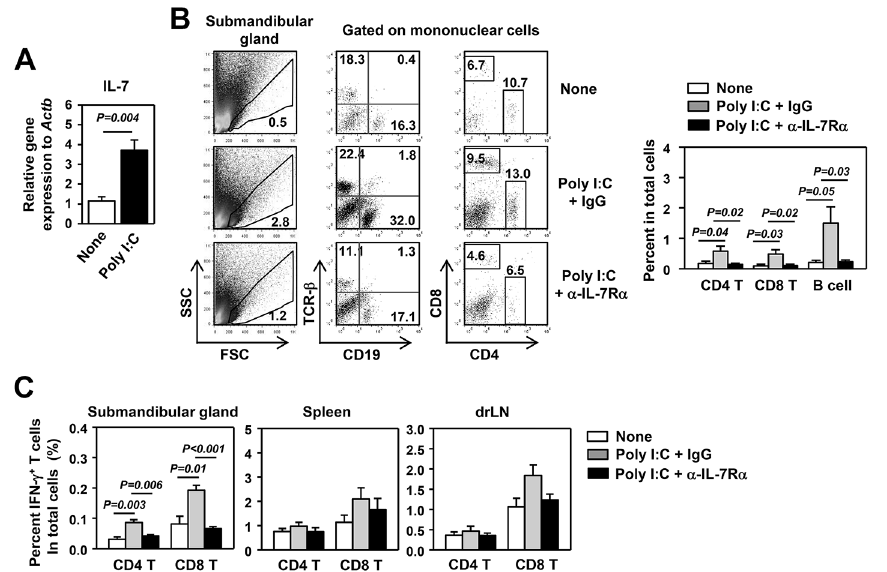
Figure 5. Poly I:C enhances Th1 and Tc1 responses in an IL-7-dependent manner. B6.NOD- Aec mice were injected with poly I:C plus IgG or anti-IL-7Rα antibody as described in Figure 4. (A) IL-7 mRNA levels in the submandibular glands of non-poly I:C- or poly I:C-treated B6.NOD- Aec mice. (B) Flow cytometric analyses of leukocyte subpopulations among mononuclear cells in submandibular glands. (C) Percentage of IFN-γ + T cells in total submandibular gland cells, splenocytes and dr LN cells based on flow cytometric analysis. Data are representative of or the average of the analyses of 7 individual mice (1-3 mice per experiment, total 4 independent experiments). doi: